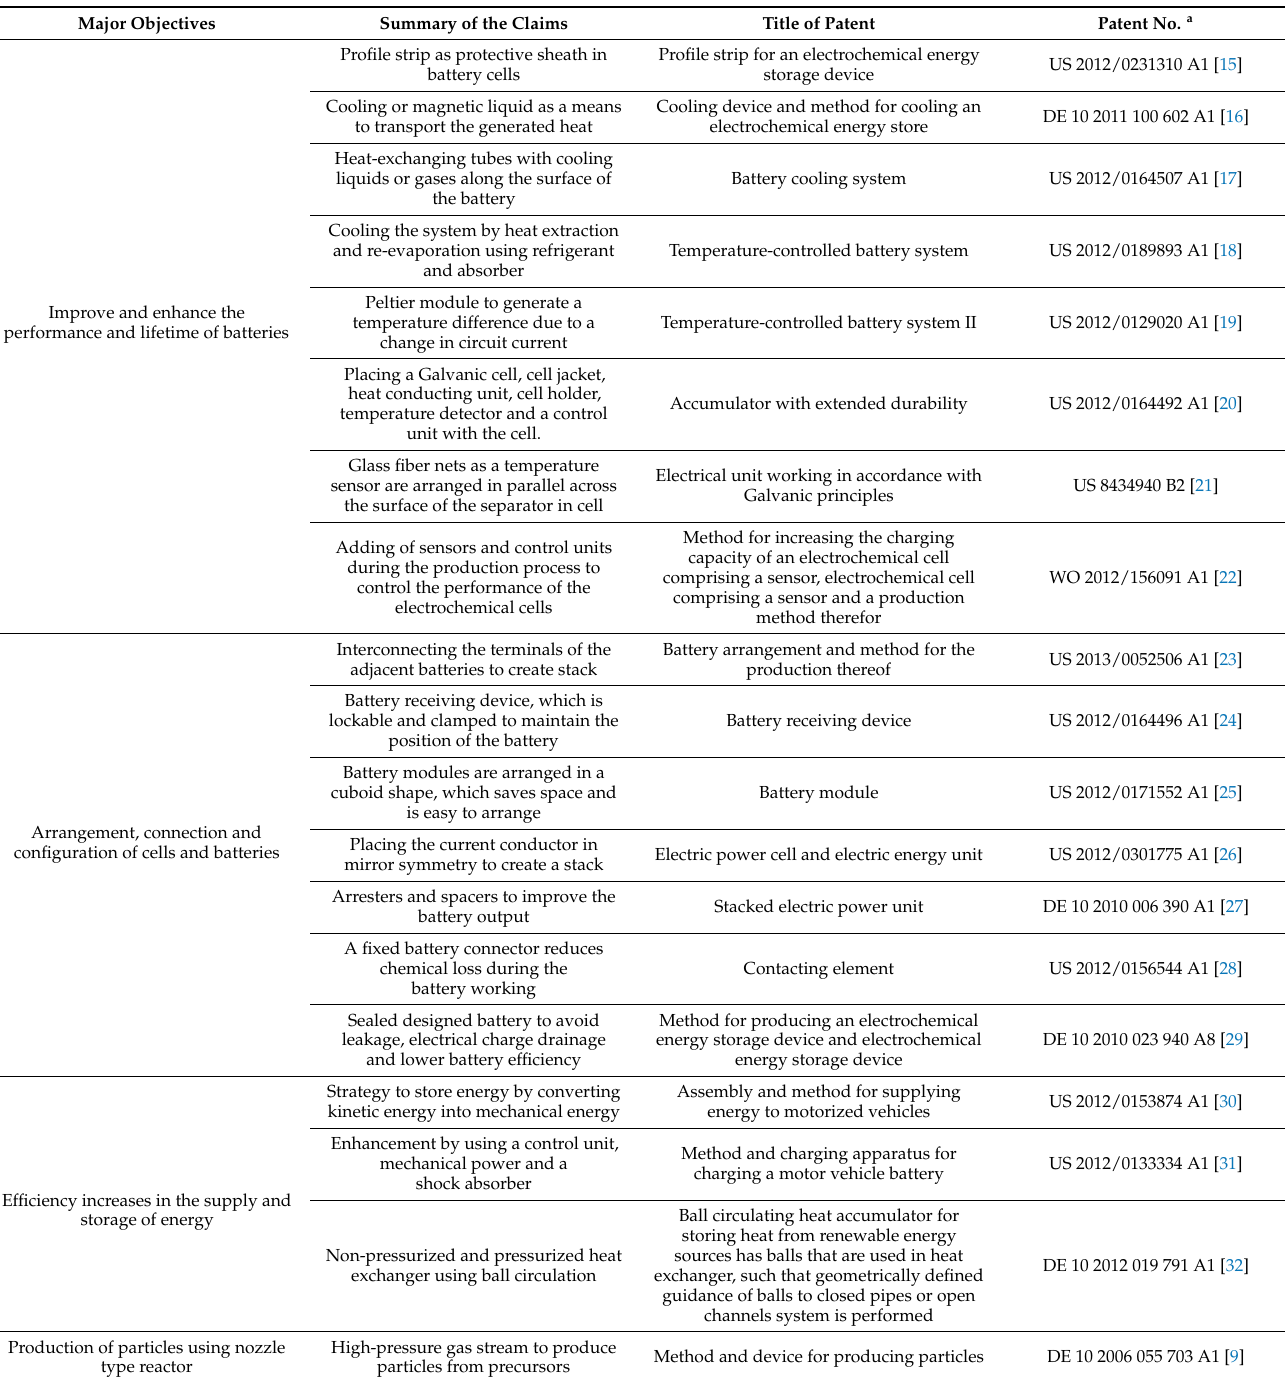
Table 2. Summary of patent claims of Walter